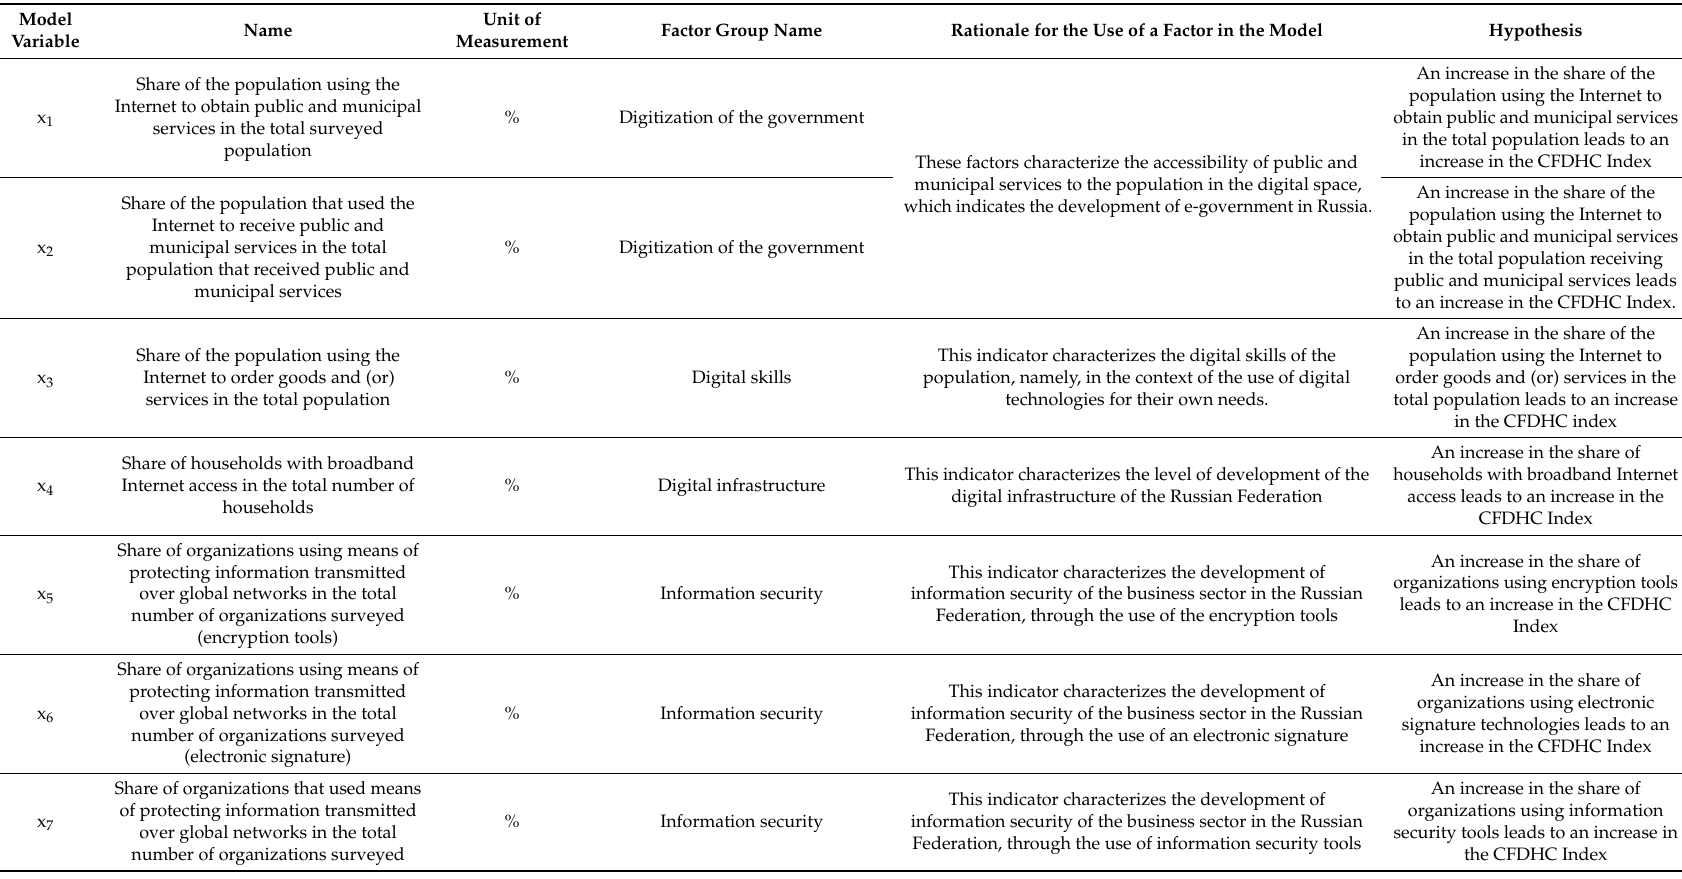
Table A1. Classification of variables-factors of